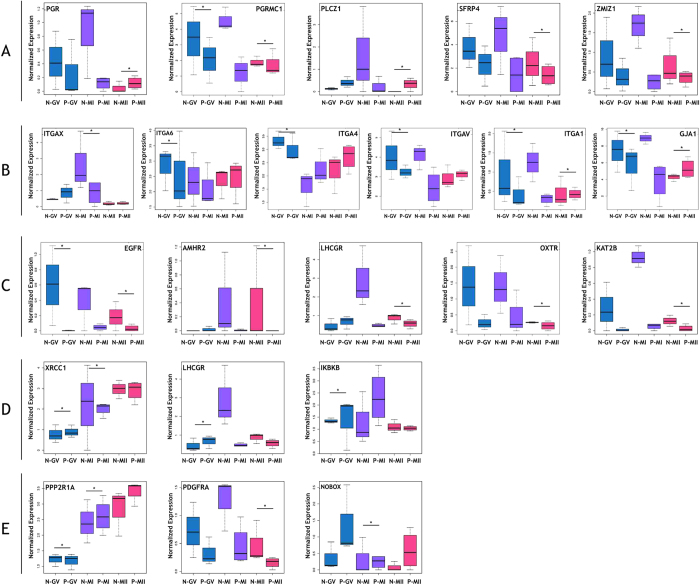
Differentially expressed genes in PCOS oocyte studied through single-cell RNA sequencing.The threshold of Padj was set at < 0.05 to find significantly expressed genes. (A) Boxplot showing differentially expressed genes involved in meiosis process. (B) Boxplot showing differentially expressed genes included in gap junction pathway. (C) Boxplot showing differentially expressed genes related to hormone receptor signaling. (D) Boxplot showing differentially expressed genes involved in DNA repairing. (E) Boxplot showing significantly expressed genes are related to secreted factors. *Padj < 0.05. The y axis indicates the log2 (FPKM + 1) expression levels.